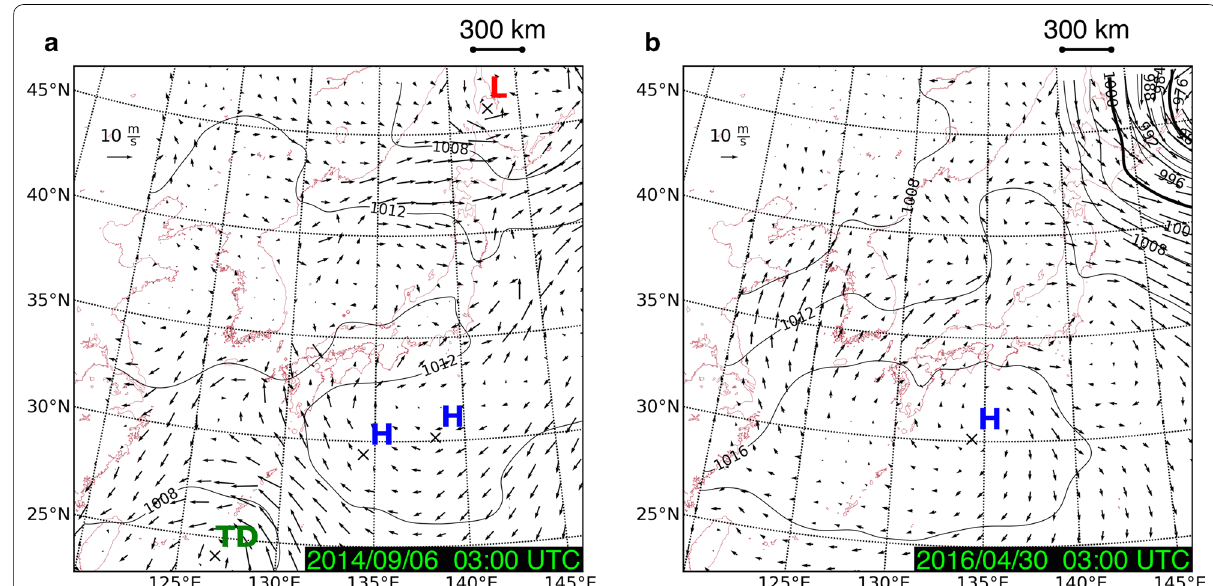
Fig. 2 MSM surface pressure and wind. Sea level pressure (contour, hPa) and surface wind (vector) created from MSM data on the SAR observa- tion days. The times of 03:00 UTC are approximately 30 min later from SAR acquisition times. The symbol “ H ” indicates the center of a high-pressure system; “ L ” indicates the center of a low-pressure system; and “ TD ” indicates a tropical